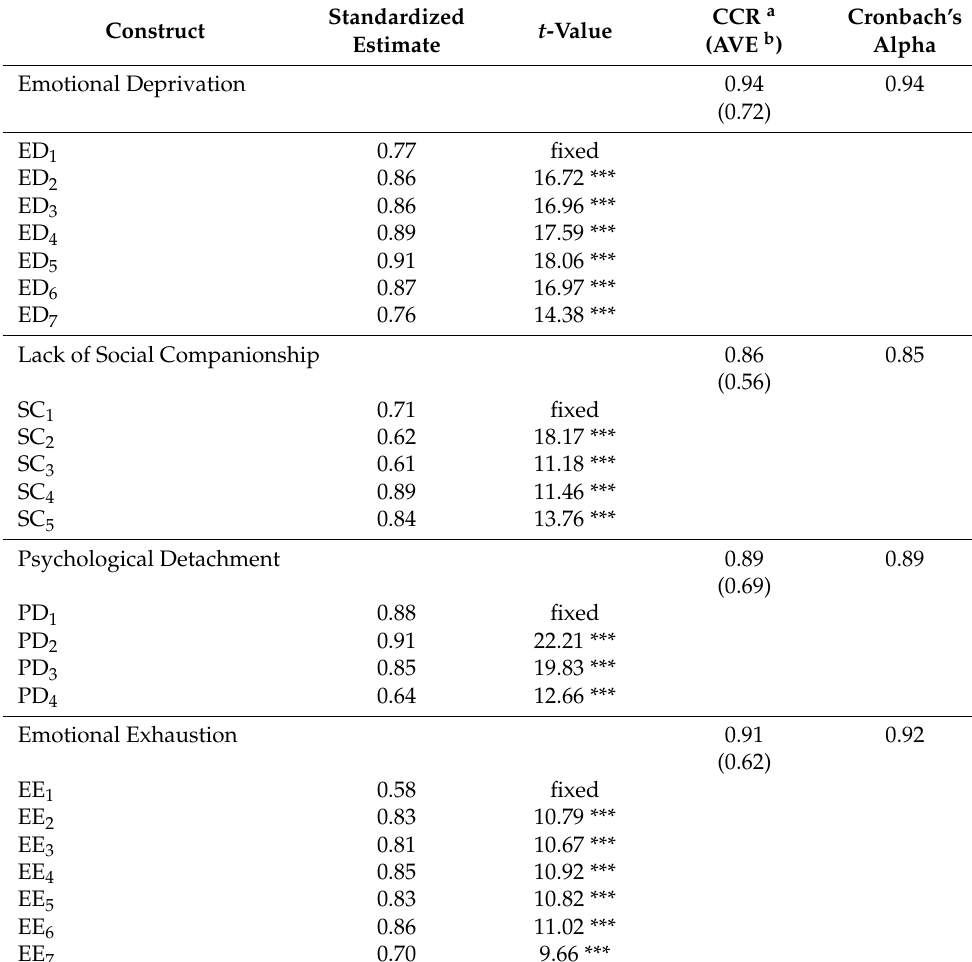
Table 3. Characteristics of reliability and confirmatory factor